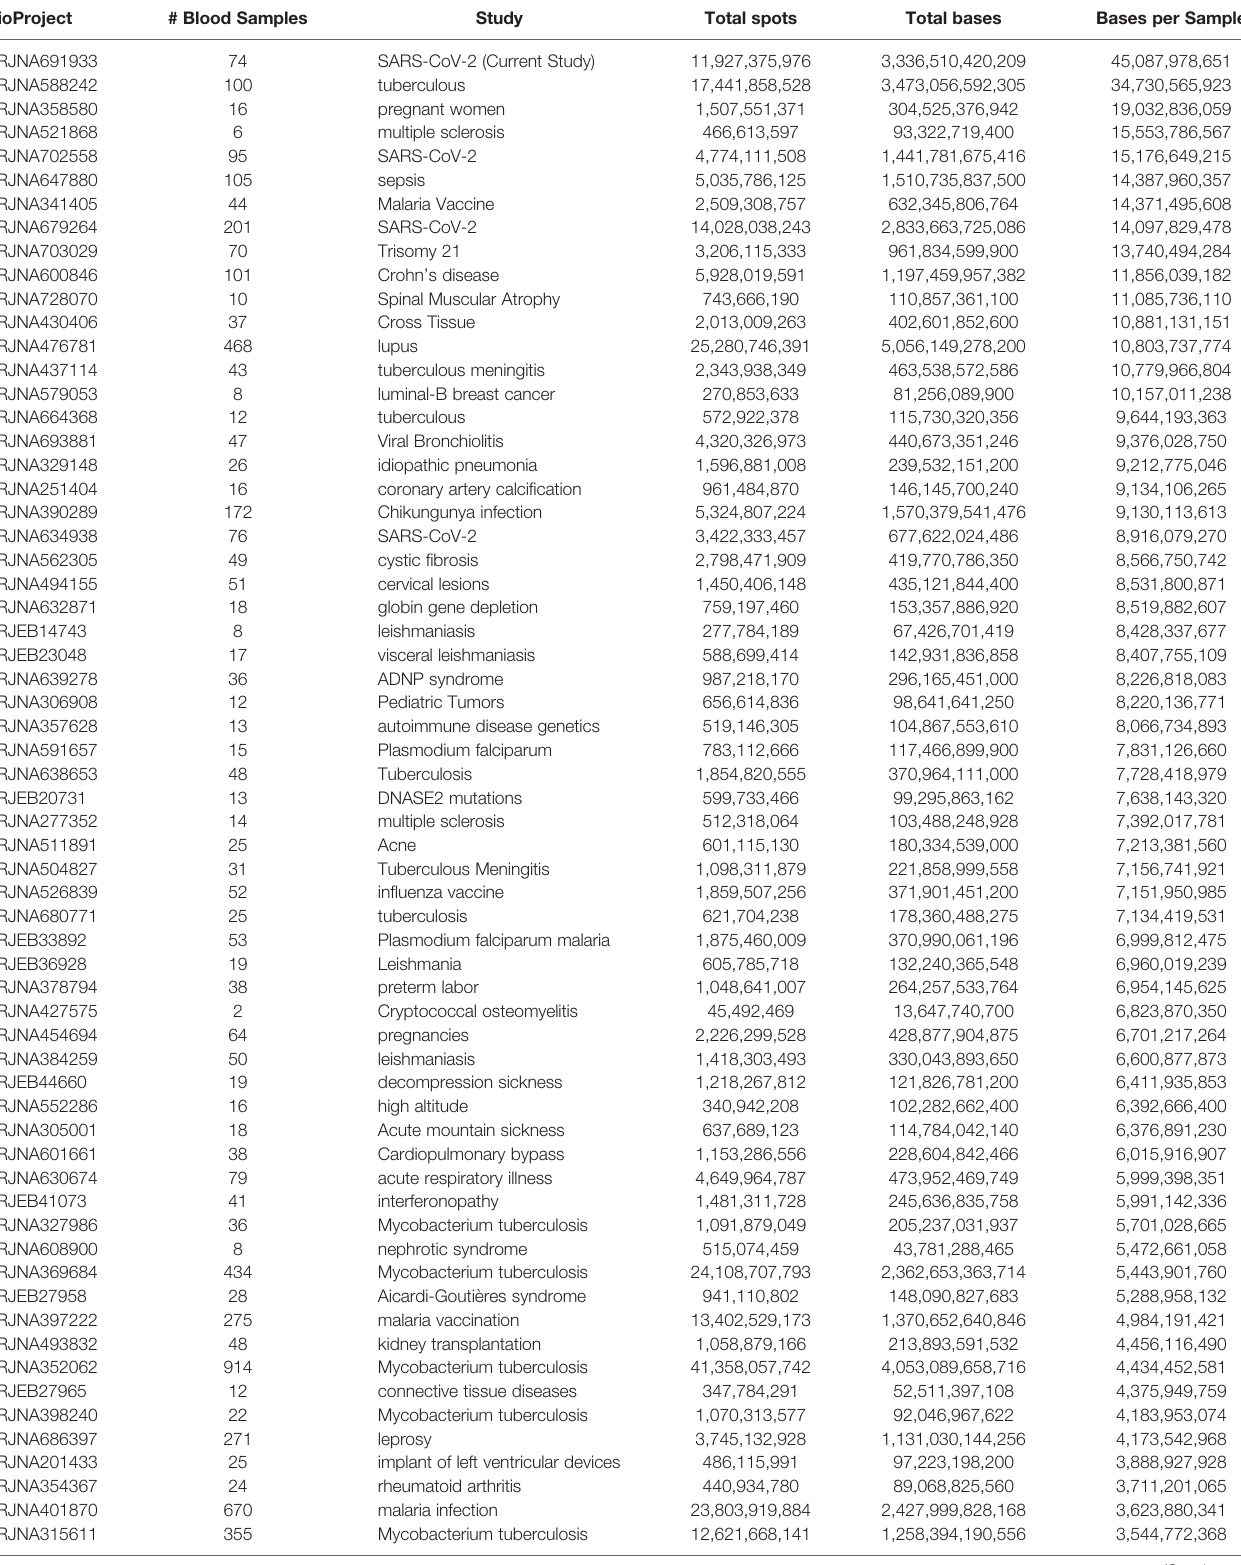
TABLE 2 | Public datasets found in each BioProject on the NCBI SRA (as of June 2021) for blood PAXgene tube RNA done in paired end with fastq fi les available. BioProject # Blood Samples Study Total spots Total bases Bases per Sample